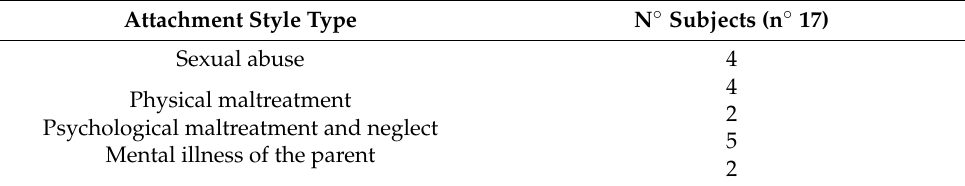
Table 1. Types of ACEs in the target group.